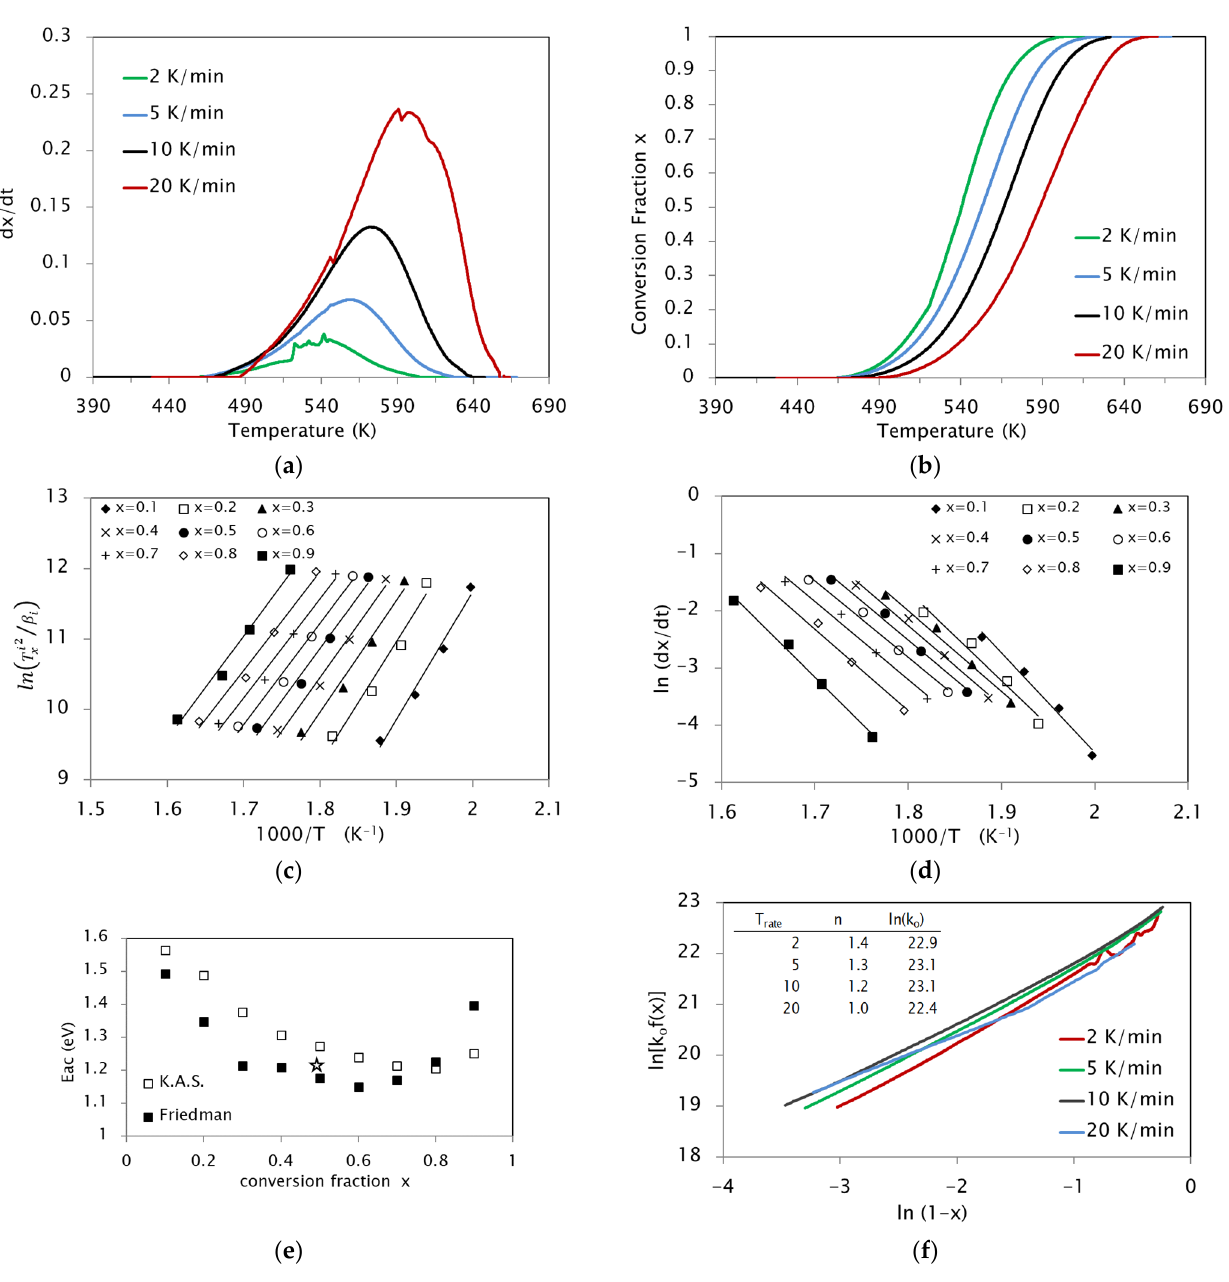
Figure 7. ( a ) (𝑑𝑥 𝑑𝑡⁄ ) curves, corresponding to DSC curves of P 1 after baseline correction, recorded during heating Cu 0 samples quenched from 970 K, at different rates β i = 2–20 K/min; ( b ) normalized integrals giving the x ( T ) curves for the different β i ; application of the Kissinger − Akihara − Sunose method ( c ), and Friedman’s method ( d ); ( e ) apparent activation energies as a function of x obtained after those methods; ( f ) plots of (cid:4670)𝑙𝑛(𝑑𝑥 𝑑𝑡⁄ ) + (𝐸 (cid:3028)(cid:3030) 𝑅𝑇⁄ )(cid:4671) vs.𝑙𝑛(1 − 𝑥) for each β i using E ac = 1.2 eV, yielding the values of n and ln( k o ) given in the inset.